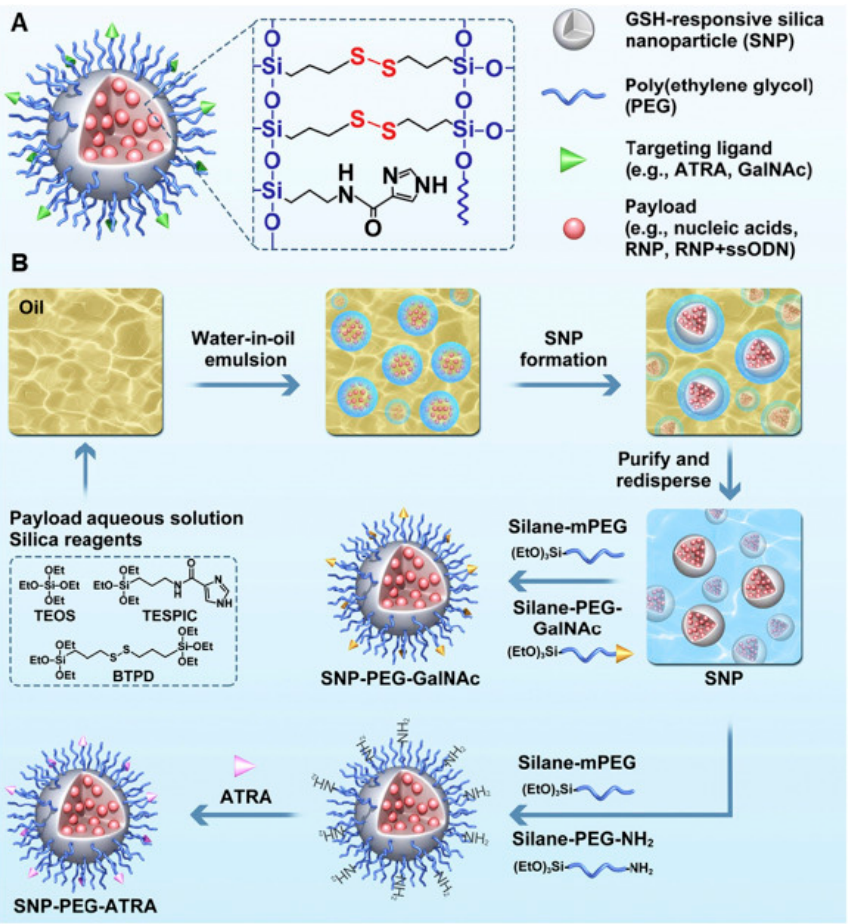
Figure 6. Design and synthesis strategy for multifunctional SNPs. ( A ) Representation of an SNP for nucleic acid and CRISPR components delivery. ( B ) Schematic for the synthesis of ATRA or GalNAc conjugated SNPs. Reprinted with permission from ref [54]. Copyright 2021, Elsevier.